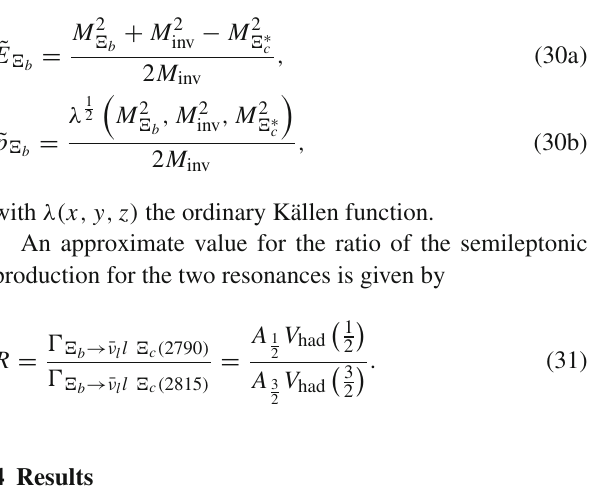
where G BD , G BD ∗ and g R , BD , g R , BD ∗ are the same as in the nonleptonic decay and C (cid:7) is again a factor that contains the matrix element ME ( q ) evaluated at the proper value of q .